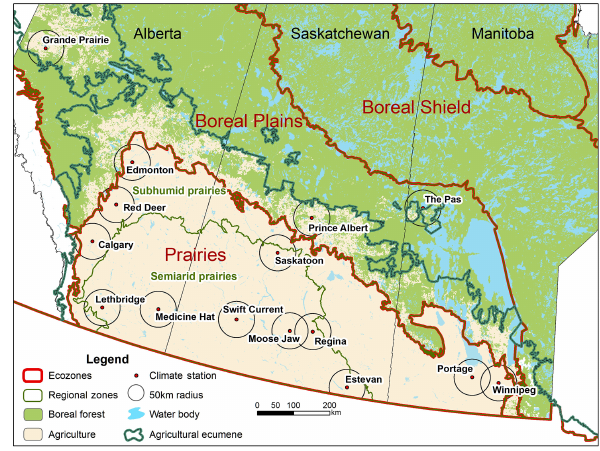
Figure 1. Climate station locations, Canadian ecozones, regional zones, agricultural regions and boreal